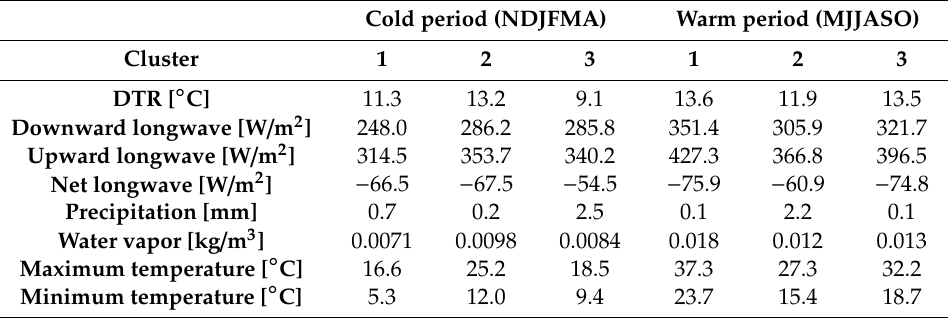
Table 3. Mean values of investigated parameters for night-time data of the suburban station for the three clusters of each